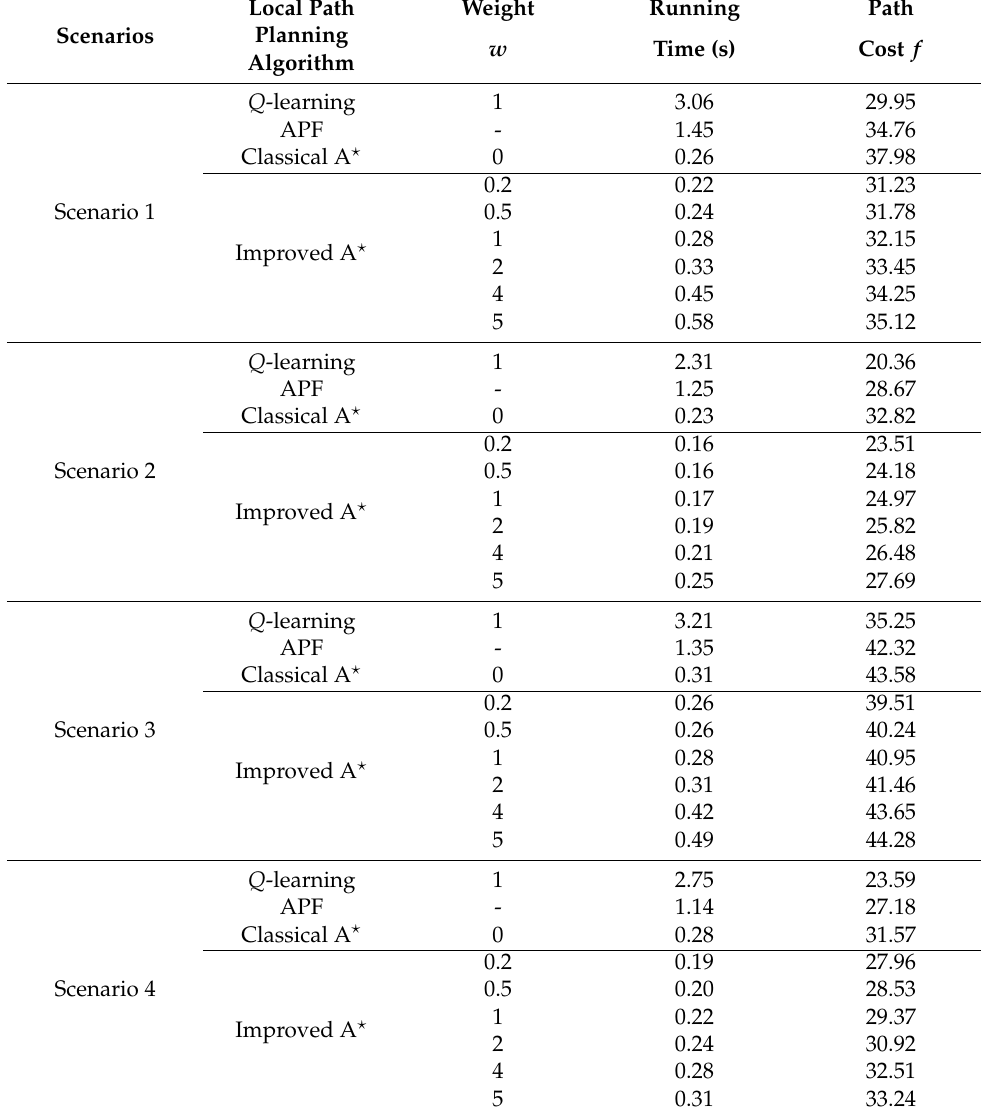
Table 2. Overall performance of the algorithms.